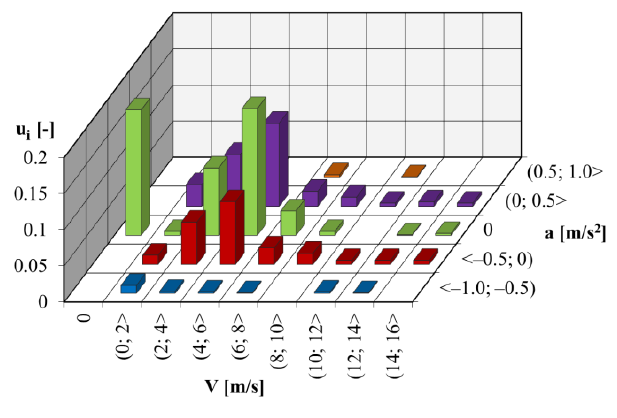
Fig. 9. Operating time density graph in real operating conditions expressed in speed and acceleration intervals